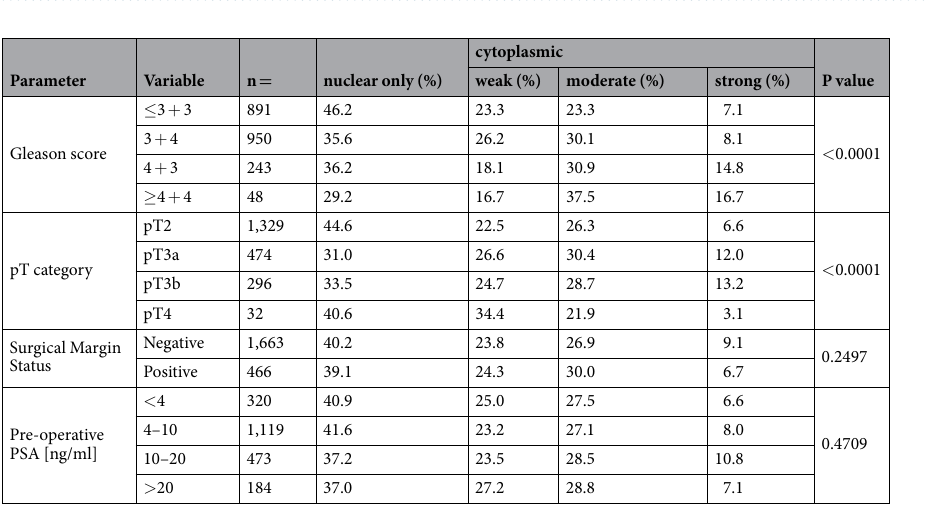
Table 1. Survivin staining intensities and frequencies in patients undergoing radical prostatectomy. Deviations from total are due to missing data in the subcategories.). Pearson’s χ 2